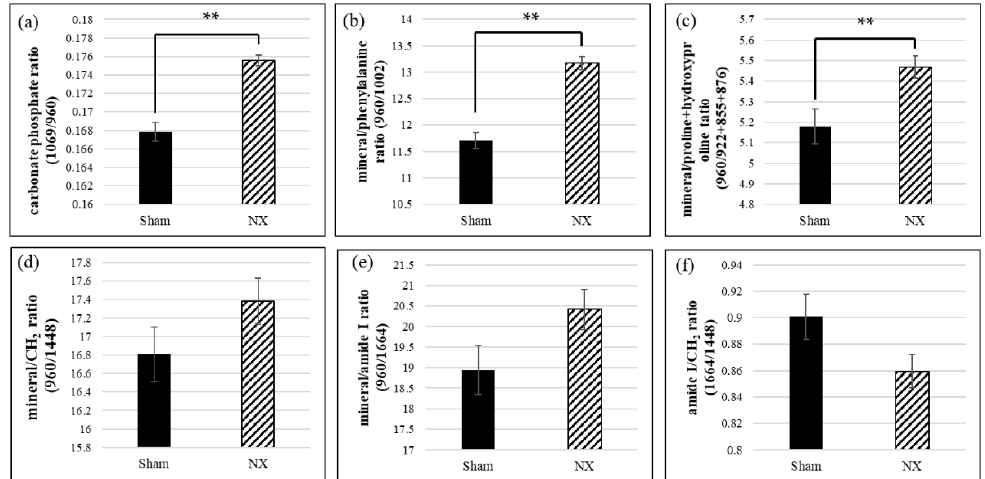
Figure 2. Raman peak intensity ratios in the NX and Sham groups. ( a ) Carbonate/phosphate ratio (1069 cm -1 /960 cm −1 ), ( b ) mineral/phenylalanine ratio (960 cm −1 /1002 cm −1 ), and ( c ) mineral/proline+hydroxyproline ratio (960 cm −1 /922 cm −1 + 855 cm −1 + 876 cm -1 ) were significantly higher in the NX group than in the Sham group. ( d ) Mineral/CH 2 ratio (960 cm −1 /1448 cm −1 ) and ( e ) mineral/amide I ratio (960 cm −1 /1664 cm −1 ) were also higher in the NX group, and ( f ) amide I/CH 2 ratio (1664 cm −1 /1448 cm −1 ) was lower in the NX group, although there were no significant differences. ** p < 0.01.